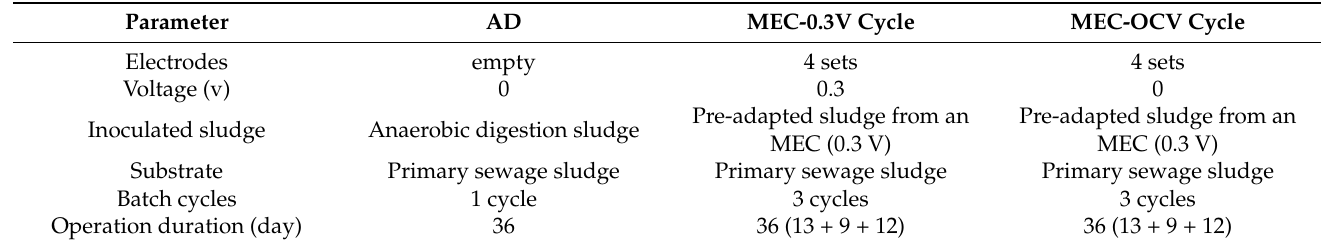
Figure 1. Schematic diagram and operating condition of ( a ) AD, ( b ) MEC-0.3 V, and ( c ) MEC-OCV. Table 2. Operational conditions in AD, MEC-0.3, and MEC-OCV.